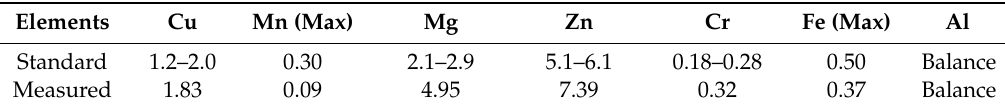
Table 1. The chemical composition of AA7075-T651 by the energy-dispersive X-ray fluorescence (EDXRF) method.